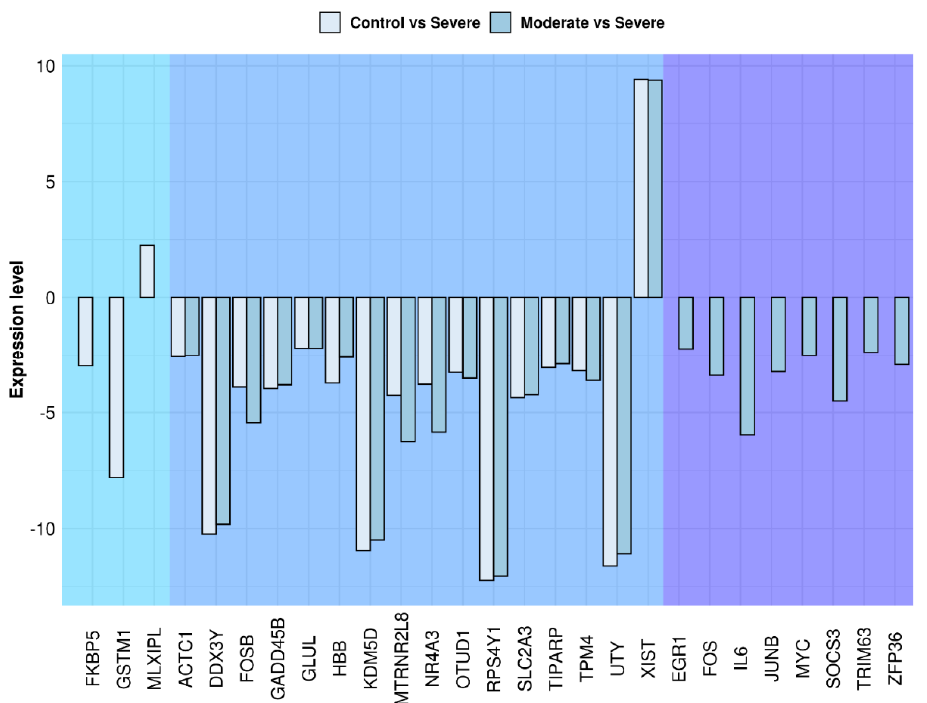
Figure 1. Differently expressed genes in the control or moderate groups against severe. The bar-plot shows that most of the genes are commonly deregulated between the two analysis (center blue frame) with similarly level of expression comparing control (grey bars) or moderate (azure bars) against severe groups. Moreover, eight genes are downregulated only in the moderate against severe analysis (right violet frame) and only three genes are deregulated comparing control against severe group (left azure frame).